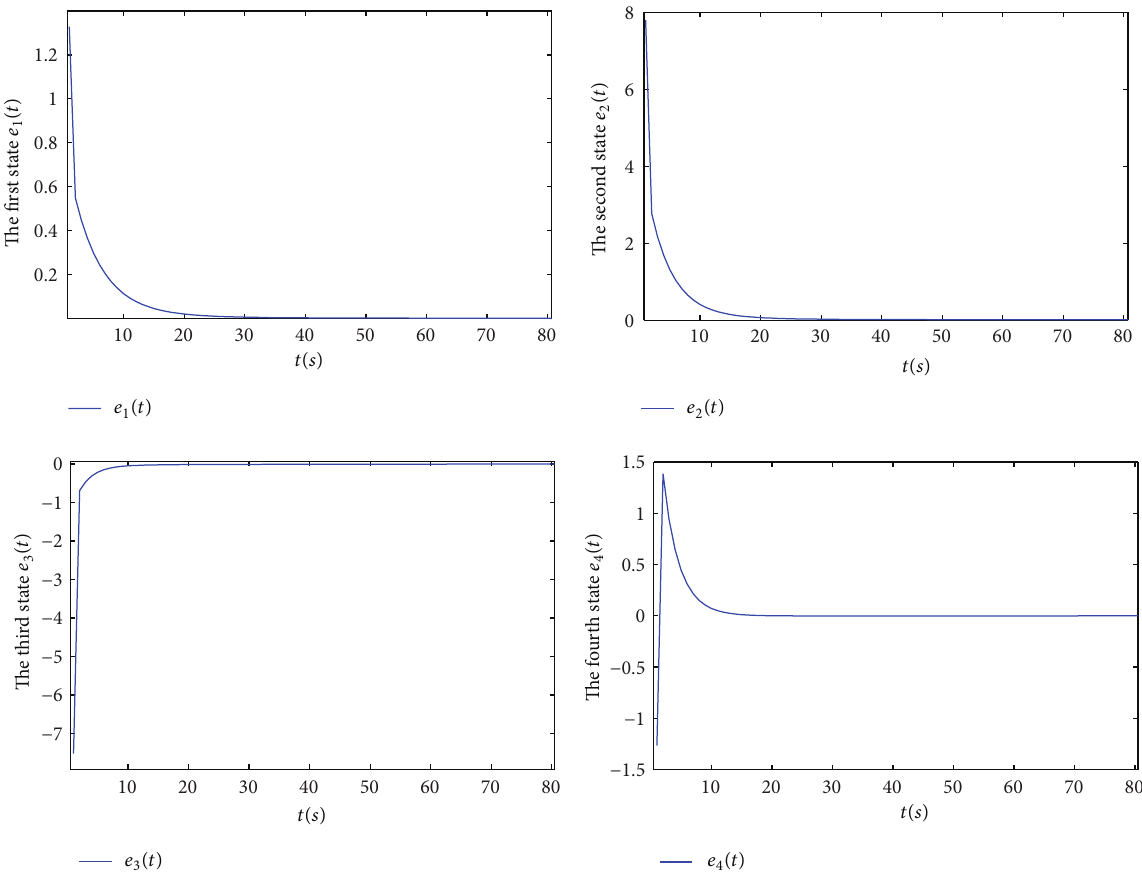
Figure 3: Response of the synchronization error (𝑒 1 ,𝑒 2 , 𝑒 3 , 𝑒 4 ) with respect to